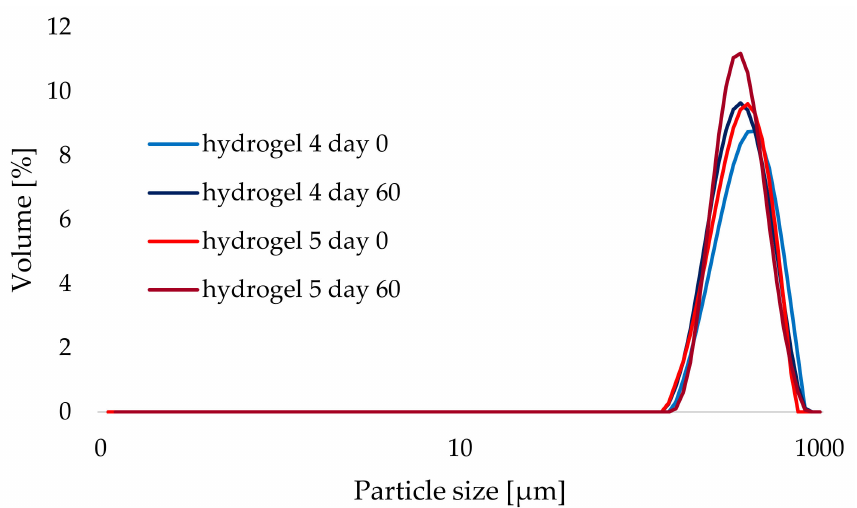
Figure 7. Comparison of particle size distribution of hydrogels 4 and 5 stored at 25 ◦ C (day 0 and day 60).